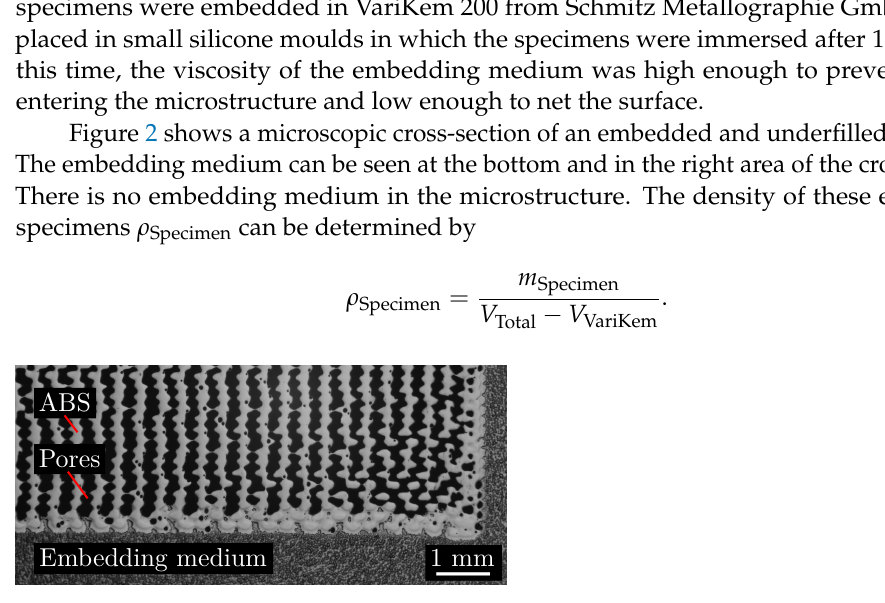
Figure 2. Microscopic image of a cross-section through an underfilled specimen embedded for the purpose of surface sealing. No embedding medium is entering the